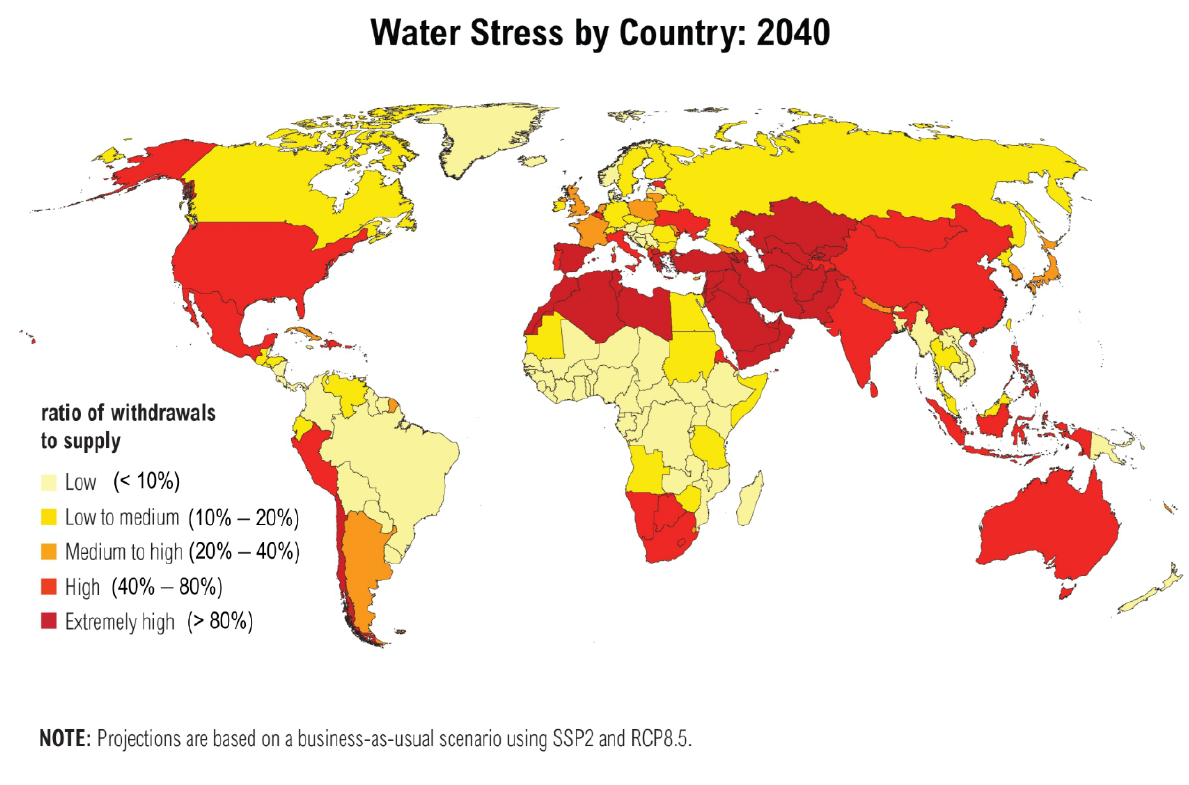
Figure 1: Predicted water stress in the world by 2040 according to